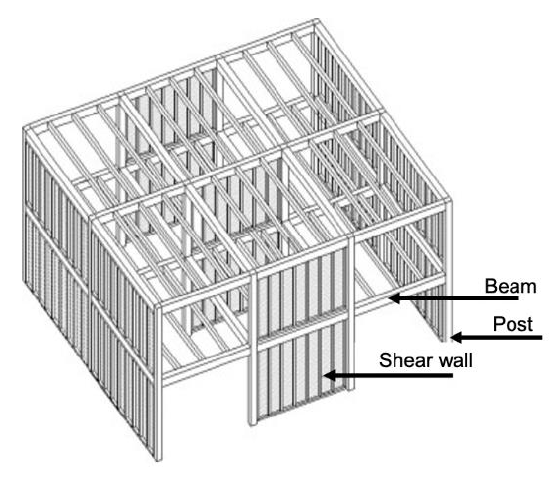
Figure 3. Example of a post-and-beam structure modified from [137].